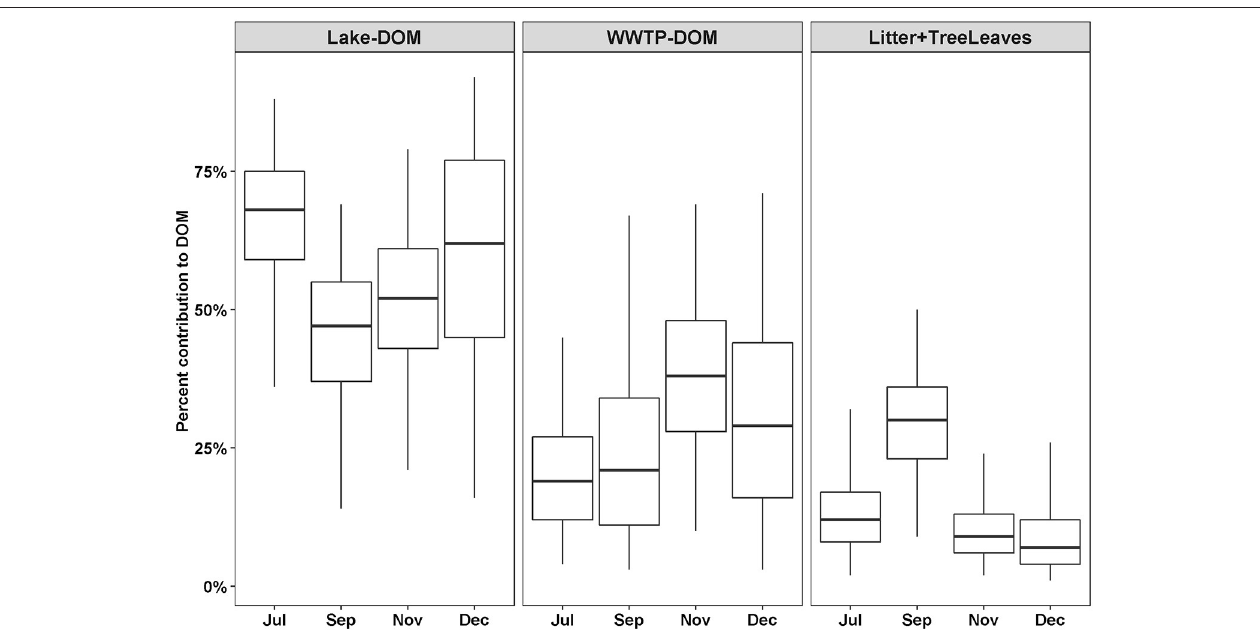
FIGURE 6 | Percent feasible contributions to DOM from three sources depending on the month. Contributions were estimated using SIMMR with two isotope tracers, δ 13 C and δ 2 H. Boxes represent the median and interquartile range; whiskers represent 2.5 and 97.5 percentiles.